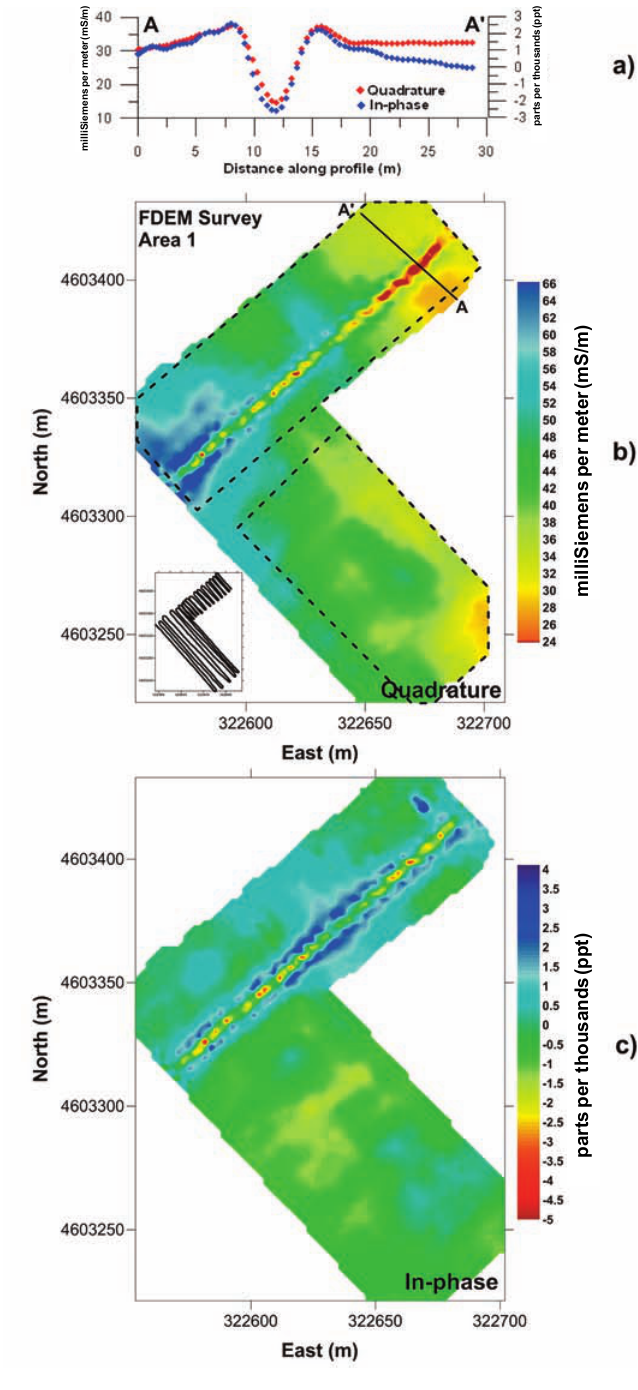
Figure 2. Map from the FDEM survey. (a) Quadrature and in-phase components along profile A-A'. (b) Map of the quadrature component. Inset, FDEM measurement profiles. (c) Map of the in-phase